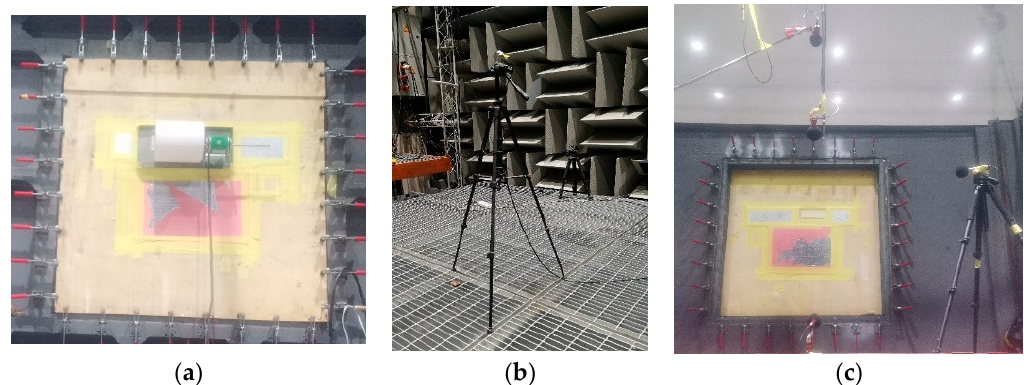
Figure 6. Test equipment: ( a ) fan and motor; ( b ) photoelectric infrared speed sensor; ( c ) microphone.